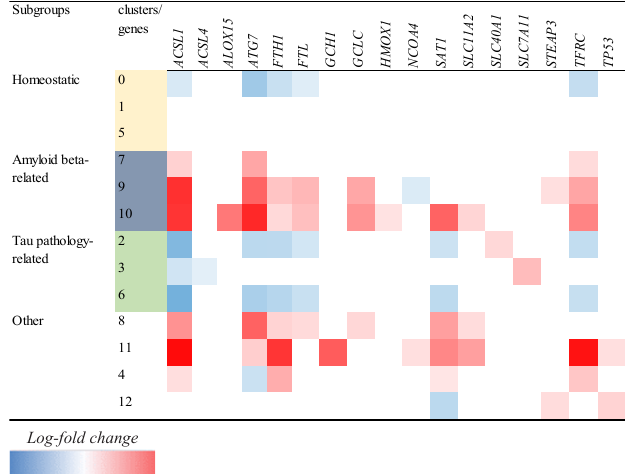
TABLE 2 | Log-fold change of ferroptosis-related DEGs in glia cells in AD. Subgroups clusters/ genes